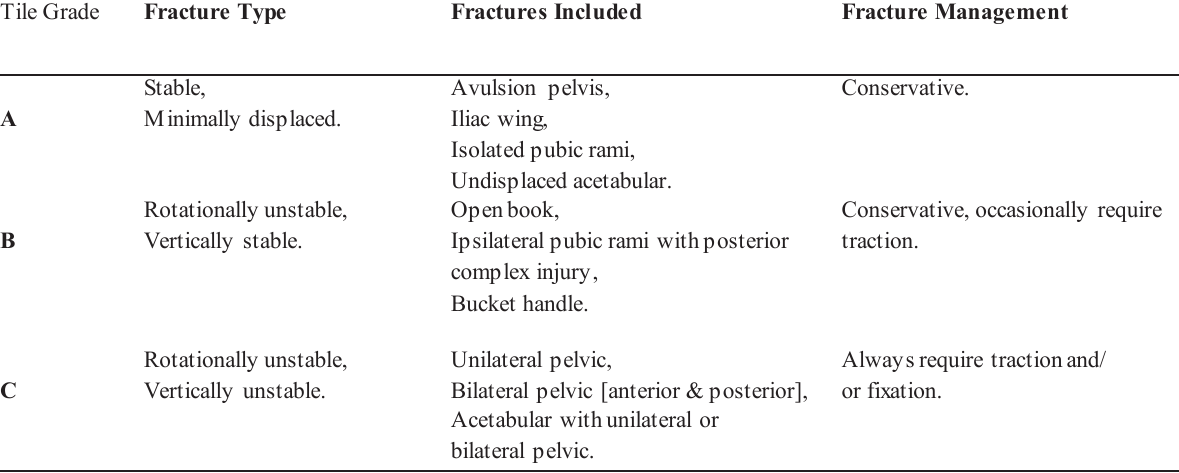
Table 1 - TILE Classification of Pelvic Fractures.